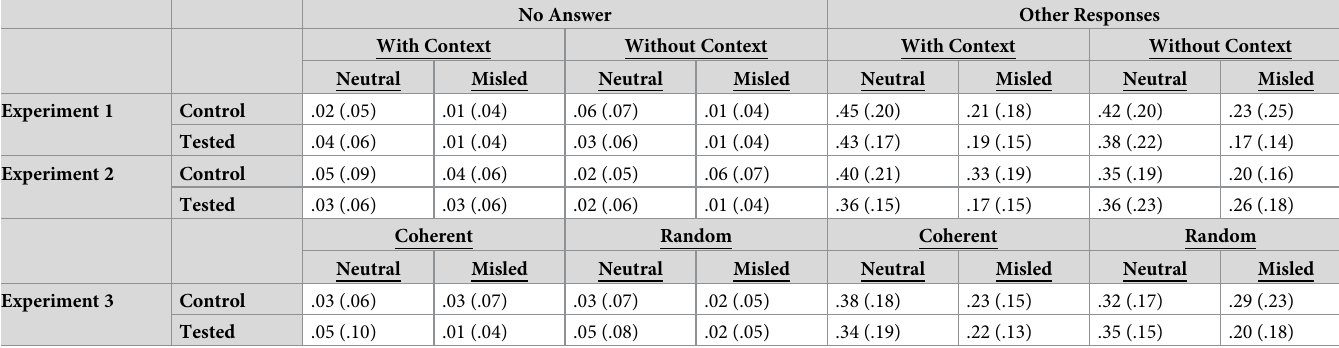
Table 3. Mean probabilities (and standard deviations) of no answer and other responses on the final test in experiments 1, 2, and 3. No Answer Other